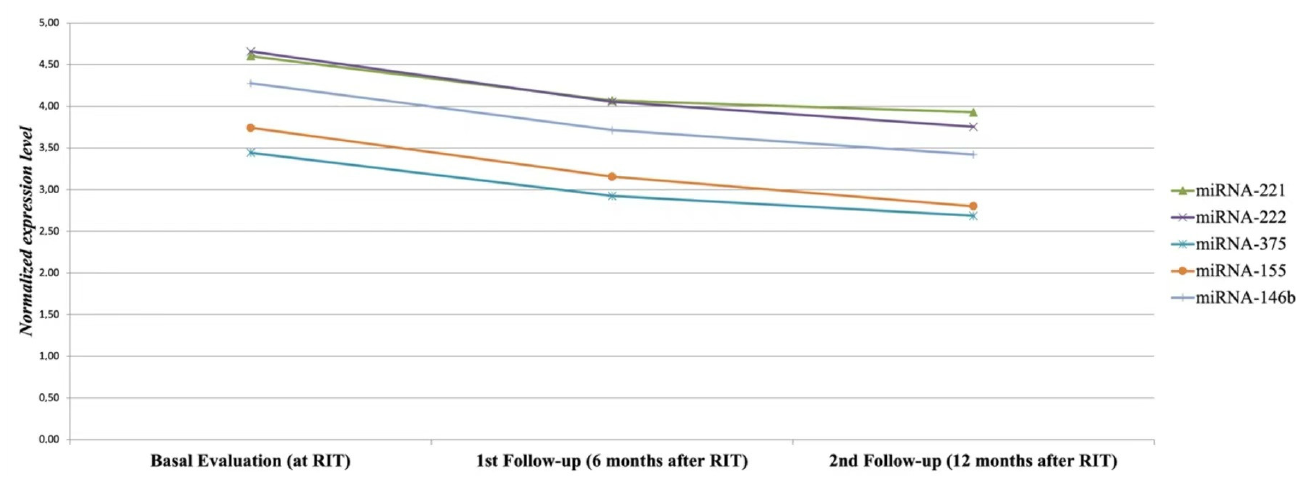
Figure 3. Serum miRNAs reduction rate between basal evaluation and first follow-up (<50%) in PTC patients with less than excellent (i.e., IndBR or ISR) response to initial therapy. Dynamic monitoring of circulating miRNAs, showing serum miRNAs reduction rates <50% during the follow-up in patients with BIndR/BIR or SIR (6 and 2 patients, respectively).